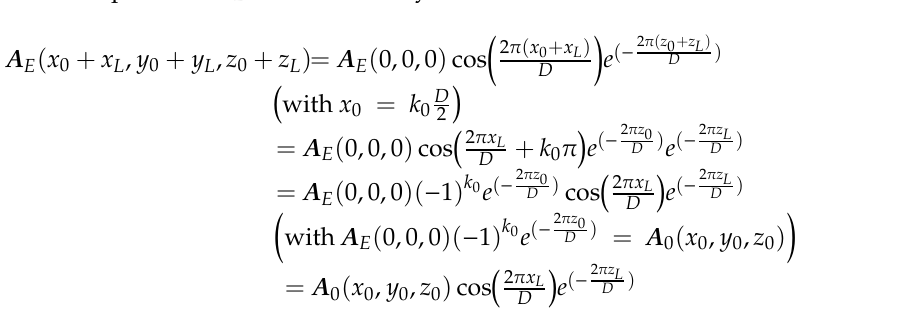
Figure A3. Body at position x 0 in front of the undulator. Figure A3 . Body at position 𝑥 0 in front of the undulator